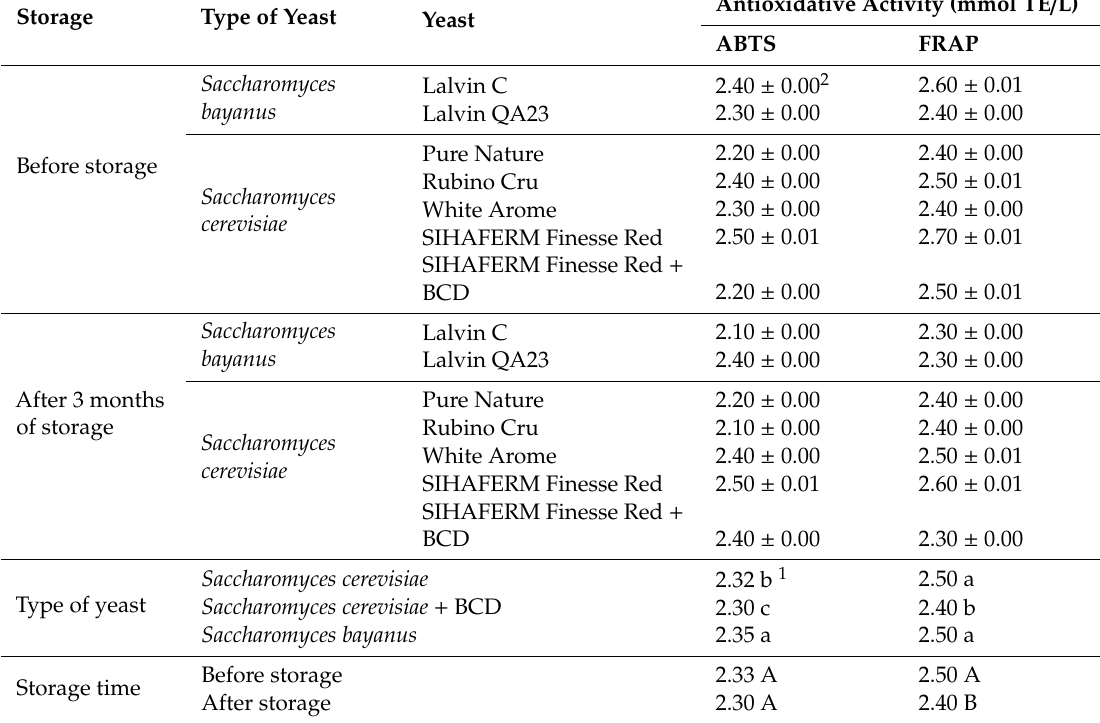
Table 5. The antioxidative capacity in red apple ciders before and after storage. TE—Trolox